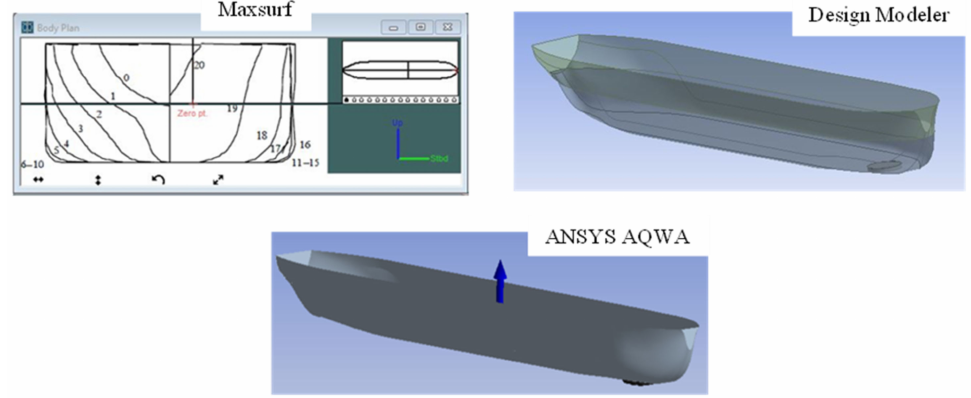
Figure 1. FPSO modeling procedure.